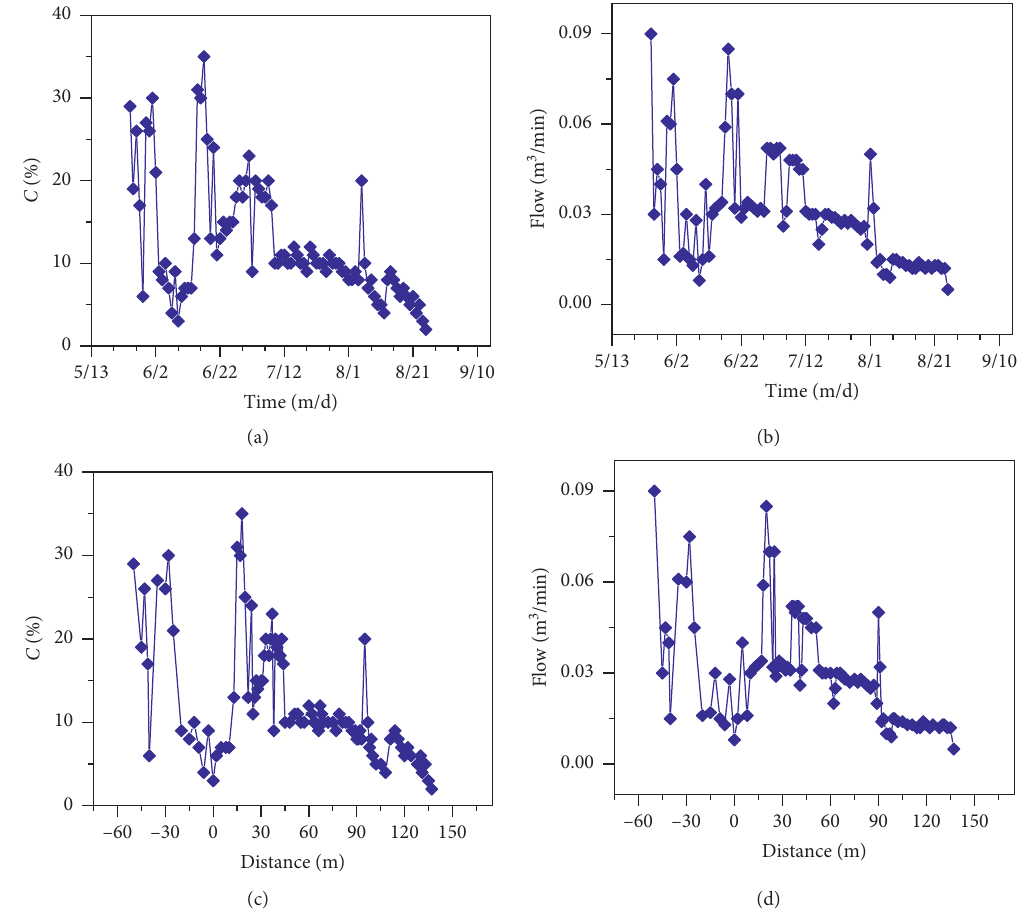
Figure 10: Gas monitoring data in no. 1 borehole of group 15.